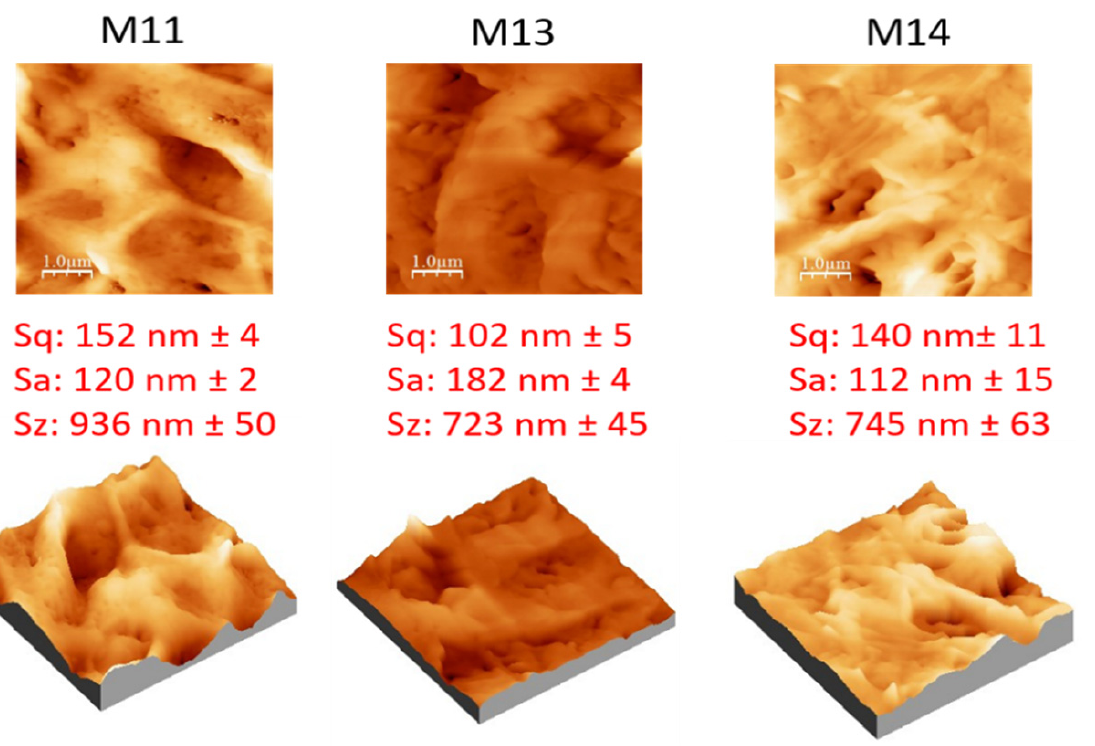
Figure 13. Mechanical properties of M11, M13 and M14 membranes. 3.4. Water Permeability, Rejection Tests and Comparison of the Results with the Literature The performance of all of the membranes prepared at the intermediate exposure time to humidity of 2.5 min and using water as a coagulation bath (M2, M5, M8 and M11) were studied in terms of hydraulic permeability and rejection to MB dye. As can be seen from Figure 14, the water permeability of each membrane was in line with pore size data. M2 and M5 membranes, exhibiting a UF pore size of 0.05 µm, showed the same values of water permeability (about 3200 L/m 2 h bar). As the pore size further increased in MF range, with M8 and M11 membranes, the water permeability also in- creased, reaching a value of almost 40,000 L/m 2 h bar. MB rejection (Figure 14) reached the maximum with the M2 membrane (83%), while it decreased with the increase in pore size (72% for M11 membrane).